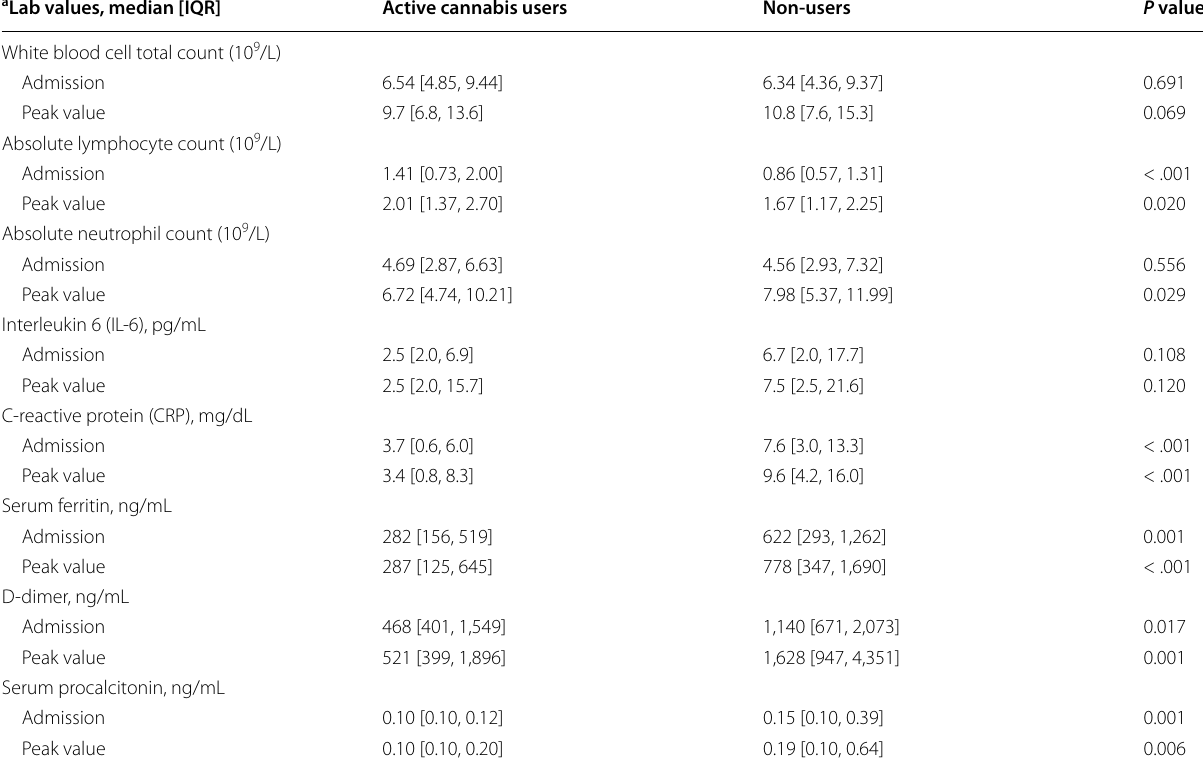
Table 4 Comparison of laboratory values at admission and peak value during the hospital stay comparing subjects who did and did not use